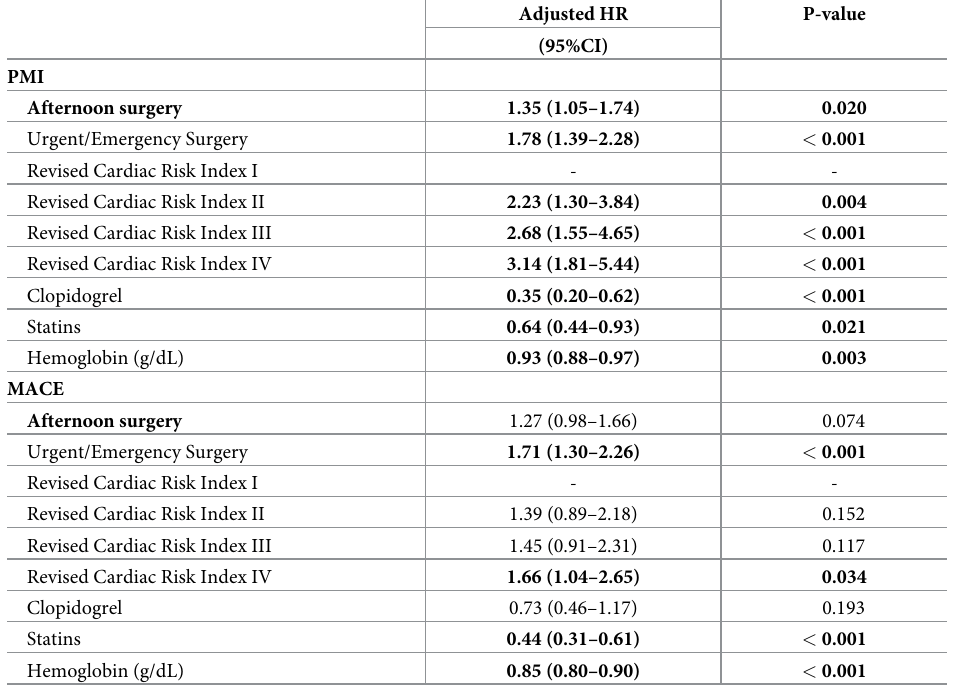
Table 4. Multivariable analysis by Cox regression model—PMI and